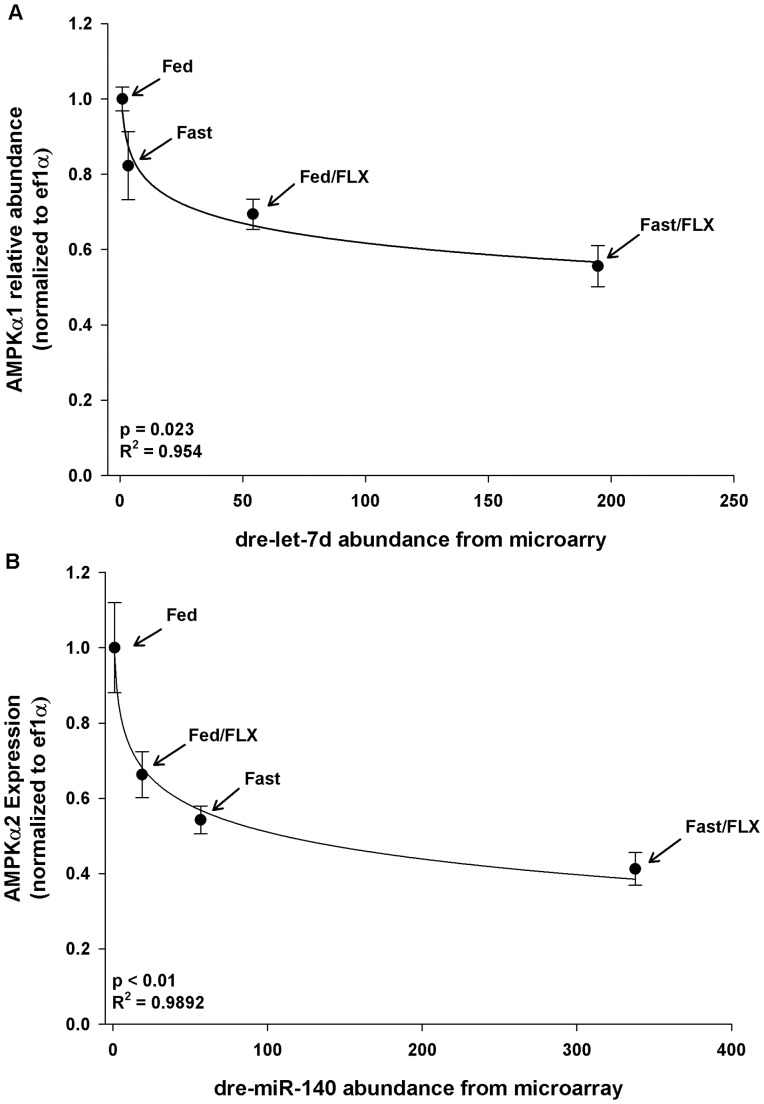
Relationship between miRNA abundance (from microarray experiment) of (A) dre-let-7d to AMPKα1, and (B) dre-miR-140a to AMPKα2.Values for AMPK relative transcript abundance are presented as the average ± S.E.M. (n = 4).